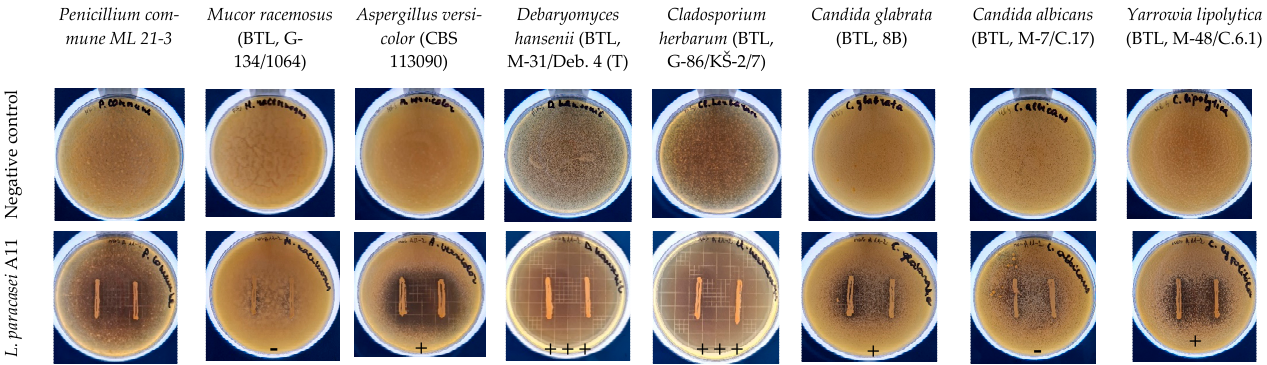
Figure 2. Activity of L. paracasei A11 isolate against four different moulds and four different yeasts after 48 h of aerobic incubation at 25 °C. Negative control shows petri plates with moulds/yeasts and without lactobacilli. The following scale was used: +++, no fungal growth on 8% of plate area/bacterial streak; +, no fungal growth on 0.1–3% of plate area/bacterial streak; -, no visible inhibition. Inhibition tests were performed in triplicate.